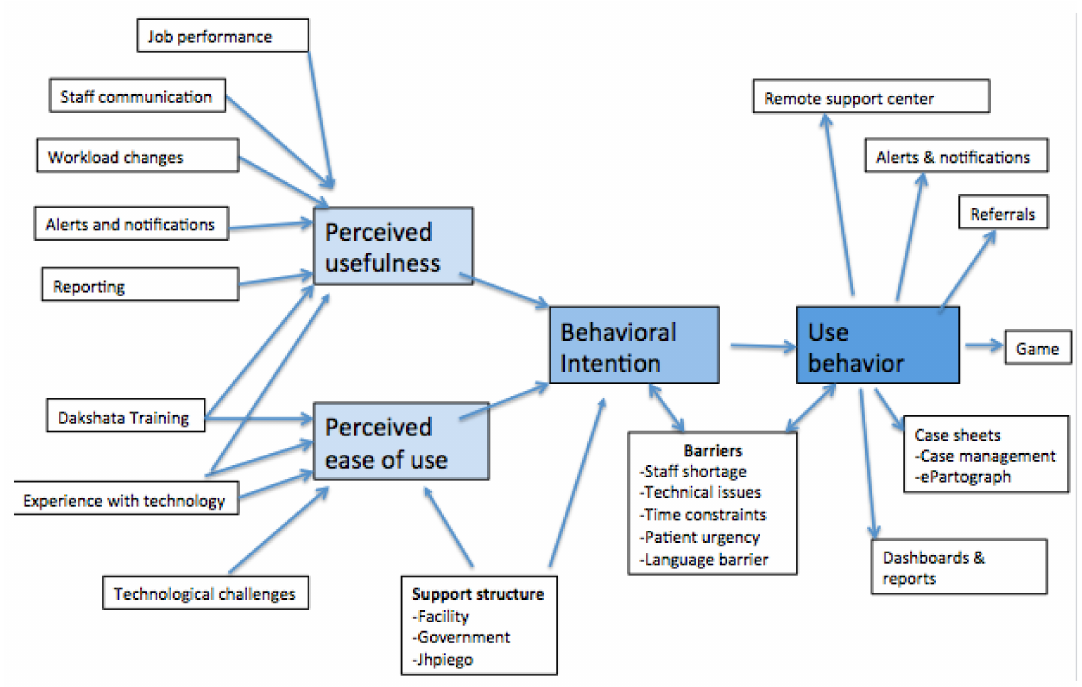
Figure 3. Adapted TAM-3 (The Technology Acceptance Model 3) based on results from qualitative findings related to the uptake of